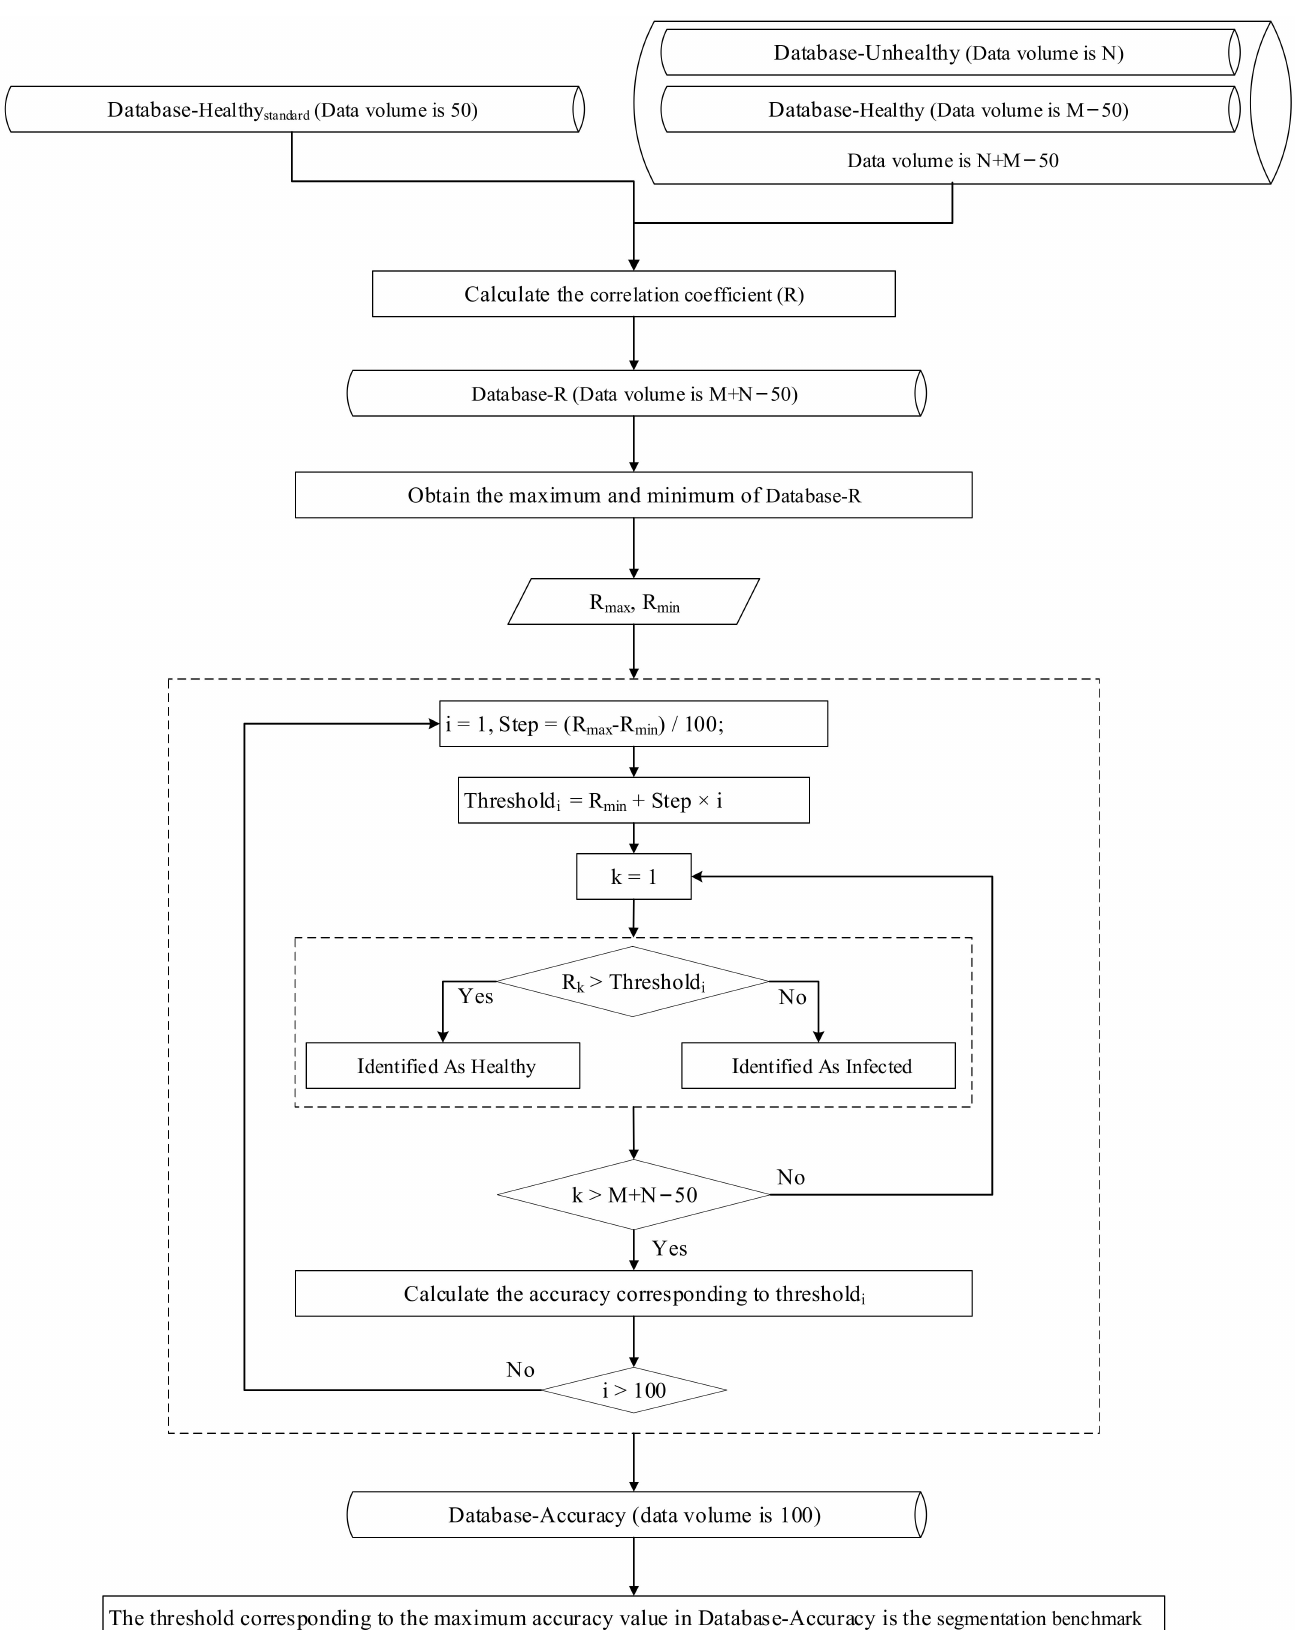
Figure 6. Workflow of proposed